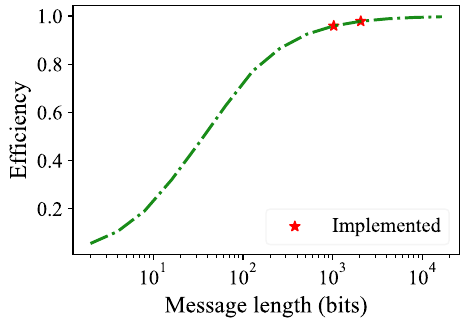
Fig. 4 Ef fi ciency of the encoding. To encode a message of length m, the ef fi ciency is m = ð m þ 2 γ Þ ; we show this ef fi ciency for different message lengths, given a fi xed security parameter β ¼ 16 .